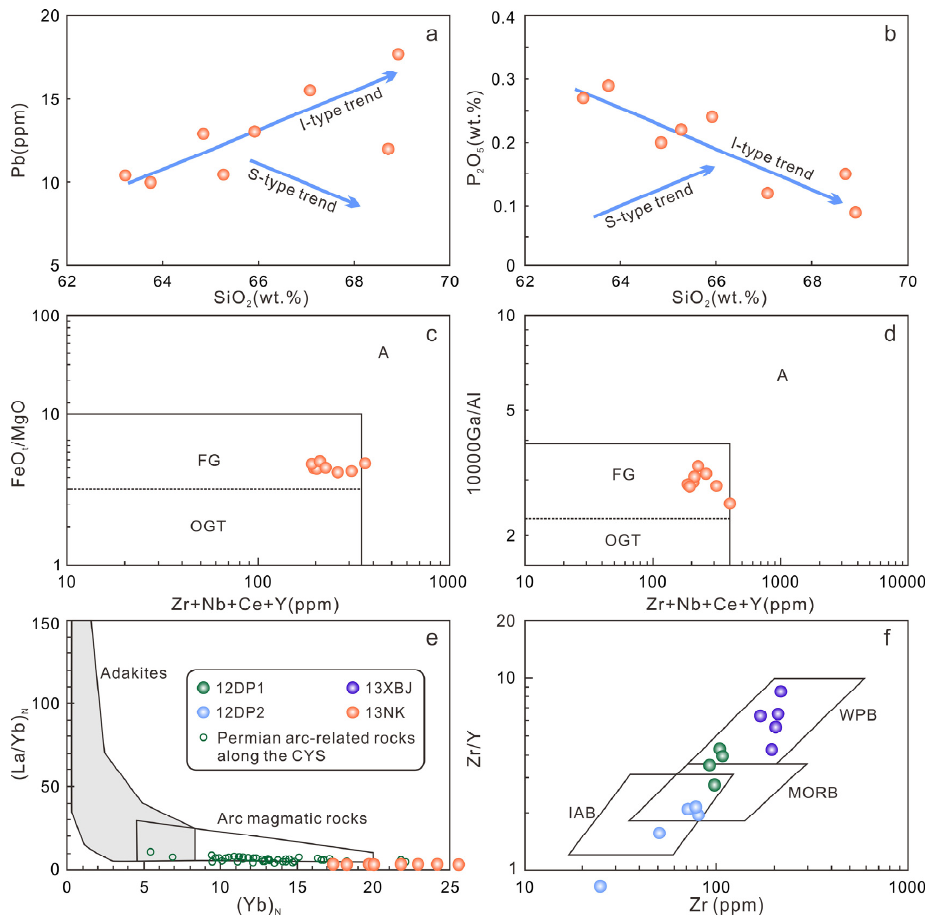
Figure 11. ( a , b ) Pb versus SiO 2 diagram and P 2 O 5 versus SiO 2 diagram showing that the felsic rocks follow the trend of I–type [ 136 ] . ( c , d ) FeO t /MgO, 10,000 Ga/Al versus (Zr + Nb + Ce + Y) discrimination diagrams to show the genetic characteristics of the felsic rocks [ 143 ] . ( e ) (La/Yb) N versus Yb N diagram for the felsic rocks [144]. ( f ) Zr/Y versus Zr (ppm) diagram for the basaltic rocks [145]. Data of Permian arc ‐ related rocks along the CYS are from the works in [35–37,40,142]. 6.2.4. Origin of the Late Permian and Late Triassic Protoliths of the Metamorphic Rocks from the KYTM Petrographic, geochemistry, and field investigations of the gneisses (12DP1 and 12DP2 samples) from the KYTM reveal that the protoliths of these rocks are subalkaline basaltic volcanic rocks. They are characterized by low MgO contents (4.05–7.86% wt%), Mg# values (45–75), and amounts of Cr (36.69–117.09 ppm), Co (16.72–40.65 ppm), and Ni (20.68–39.78 ppm), which suggest that they were derived from more evolved mafic magmas and experienced some degree of the fractional crystallization of clinopyroxene and olivine [146]. The presence of negative Ti and P anomalies indicates that this magma experienced the fractional crystallization of Ti ‐ bearing phases and apatite (Figure 5d). Moreover, the 12DP2 samples have more abundant REE concentrations and show negative Eu anomalies that indicate plagioclase fractionation (Figure 5a), as plagioclase has nearly constant partition coefficients for REE (D ≈ 0.1), except Eu.